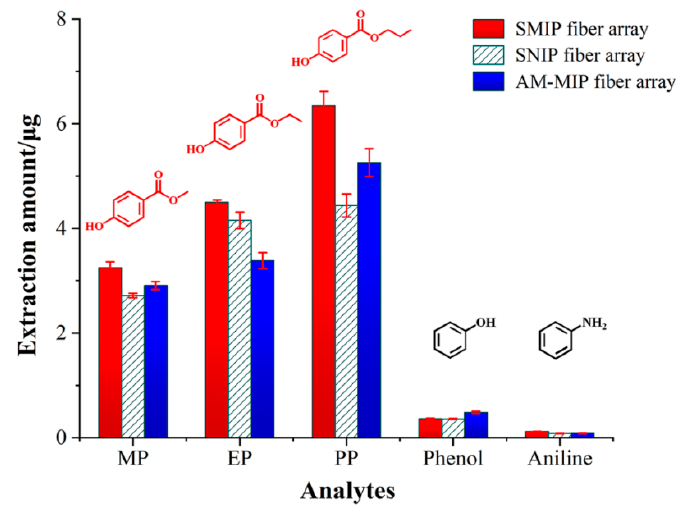
Figure 4. Selectivity study of three fiber arrays for different analytes.